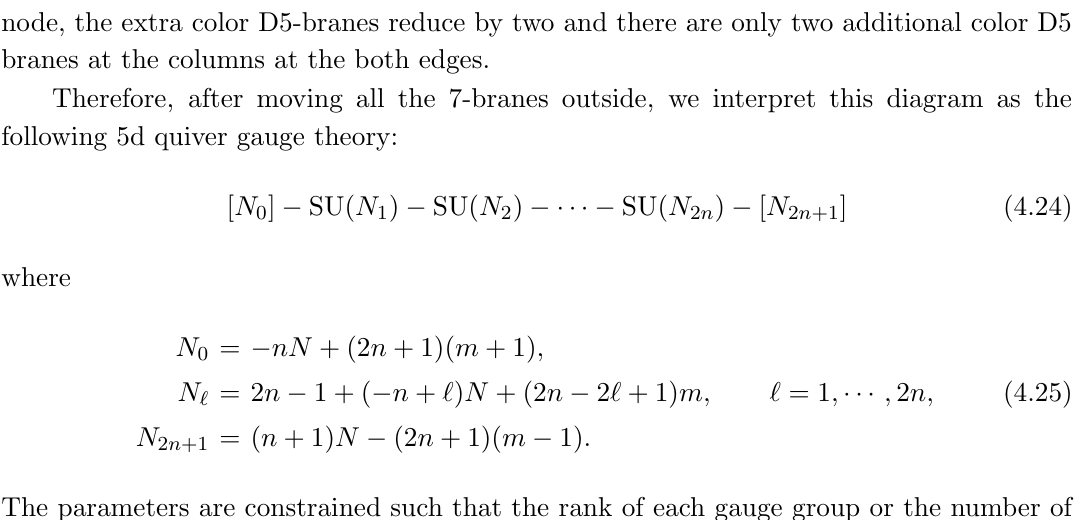
(cid:0) -planes is resolved.